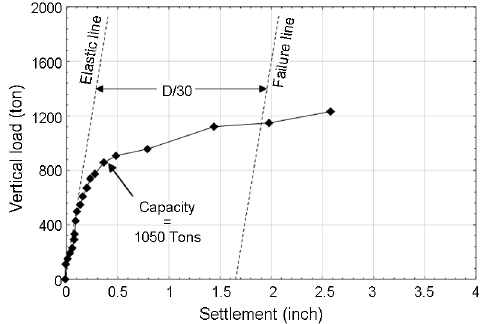
Fig. 5. Determining capacity of a driven concrete large- diameter pile for the St. Georges Island Bridge Replacement